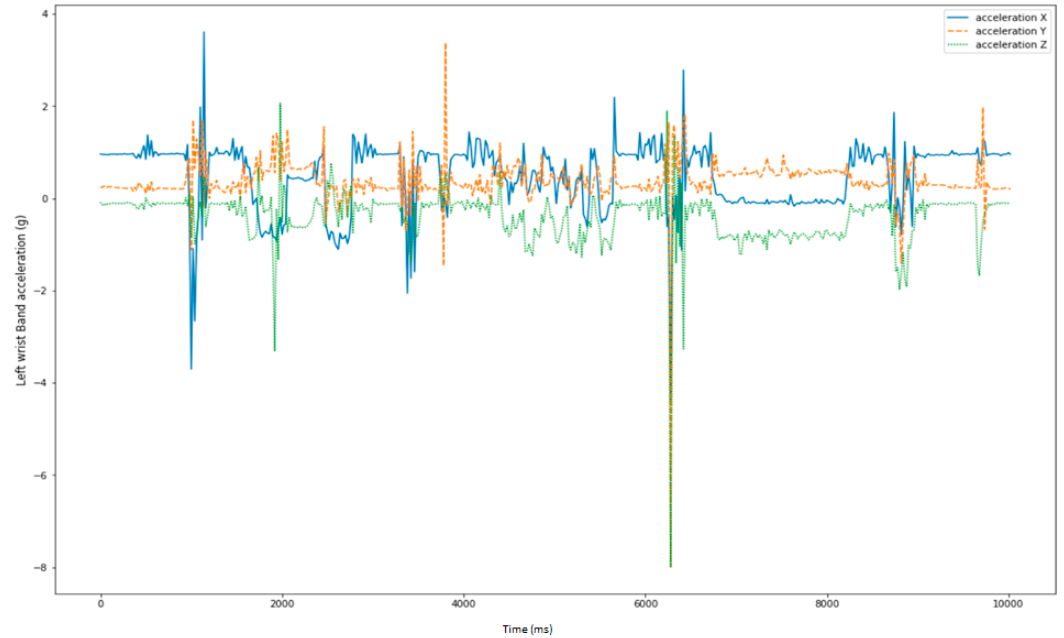
Figure 3. Tri-axial linear acceleration of participant 1. Sensors 2020 , 20 , x FOR PEER REVIEW